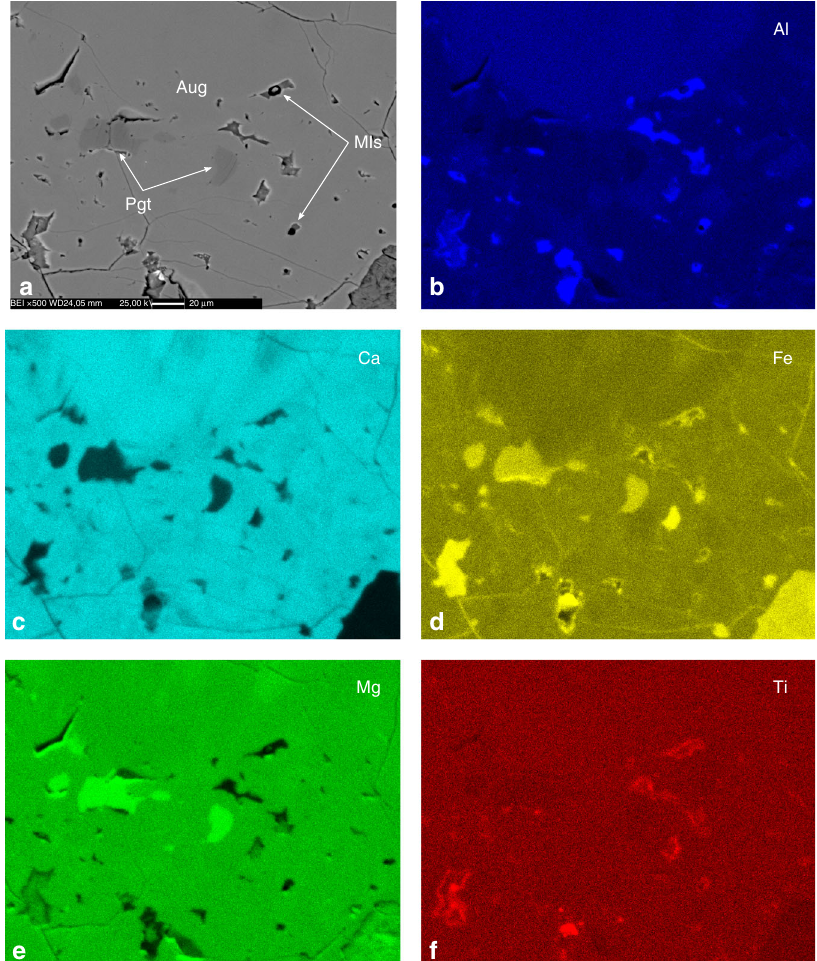
Fig. 3 Chemical maps of glomerocrystic clinopyroxene aggregates. Backscattered electrons (BSE) image a and corresponding scanning electron microscopy with energy-dispersive X-ray spectroscopy (SEM – EDS) maps b – f of a thin section area including MIs and the hosting glomerocrystic clinopyroxene aggregates. In the BSE image the brighter portions of clinopyroxene have augitic (Aug) composition and the darker ones have pigeonitic (Pgt) composition. In the SEM – EDS maps the brighter regions correspond to higher concentrations of the analysed element. These maps were acquired on sample NEW31 (New Jersey, USA). The scale bar is shown in a . a BSE image, b Al map, c Ca map, d Fe map, e Mg map, and f Ti